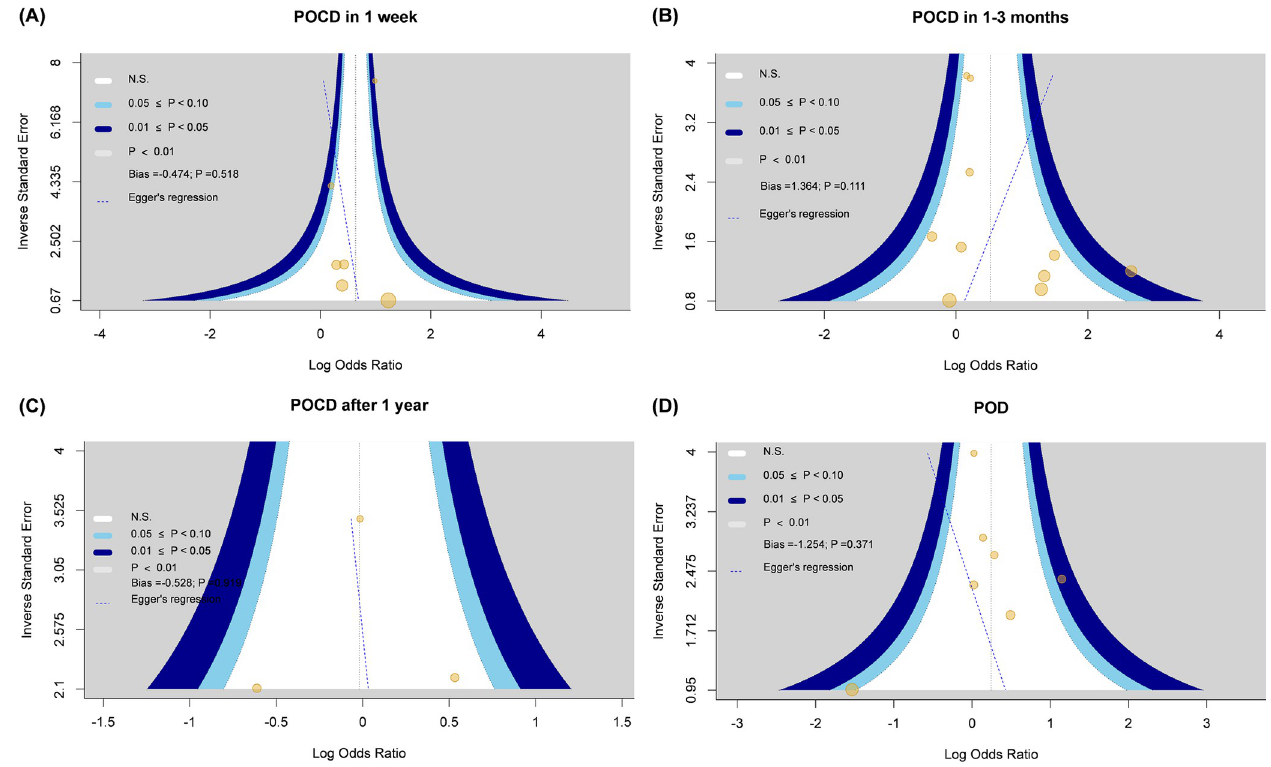
Fig 3. Small-study effect test for POCD or POD. (a) Small-study effect test of POCD at 1 week. (b) Small-study effect test of POCD at 1–3 months. (c) Small- study effect test of POCD after 1 year. (d) Small-study effect test of POD. Abbreviations: POCD, postoperative cognitive dysfunction; POD, postoperative